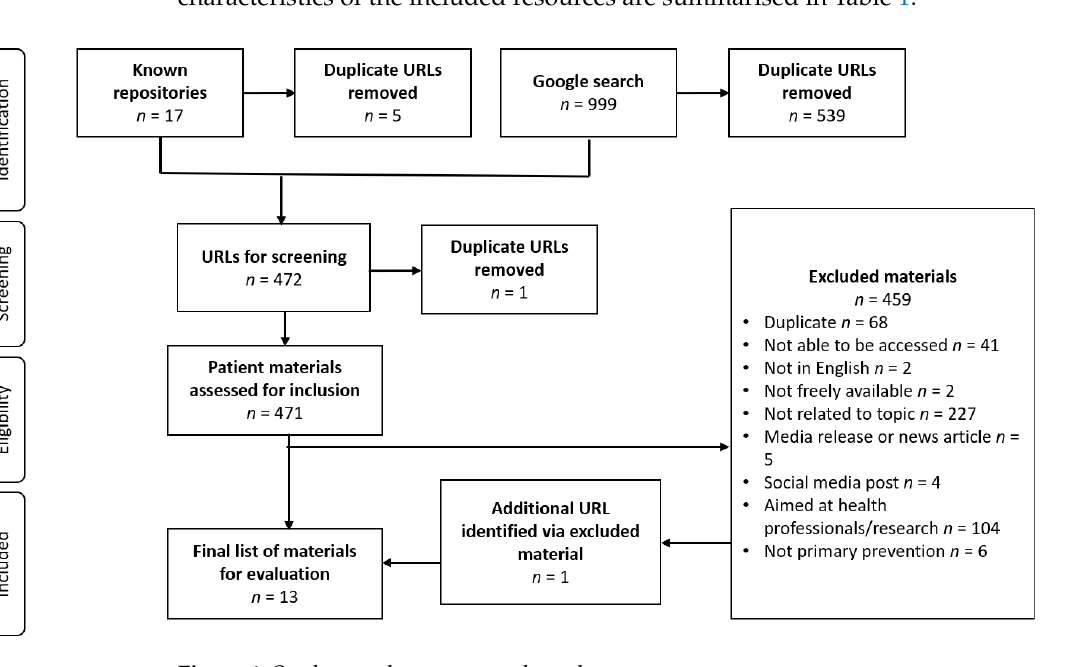
Figure 1. Study search strategy and results. Table 1. Characteristics of included online